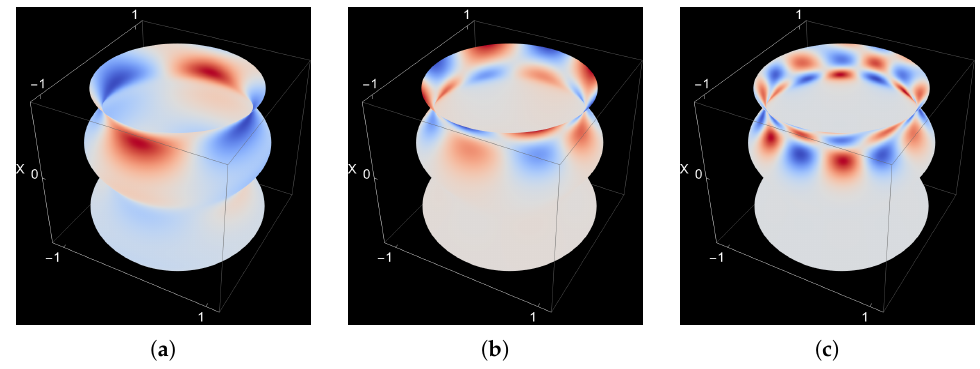
Figure 12. Case EHEH: ( a ) t = 10 − 2 . Range w ∈ [ − 3.67561,3.4307 ] . ( b ) t = 10 − 4 . Range w ∈ [ − 4382.18,4349.48 ] . ( c ) t = 10 − 6 . Range w ∈ [ − 230,286, 234,696 ] .